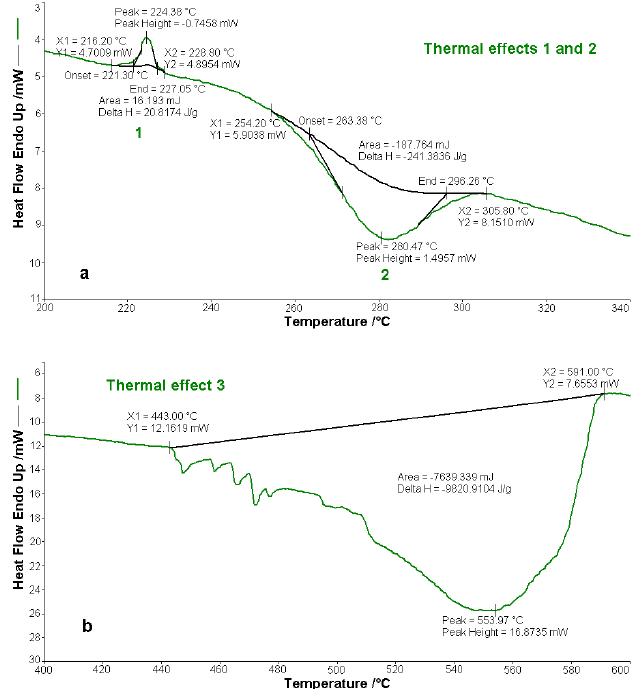
Figure 16. Thermal e ff ects of decomposition of BPA in air: ( a ) thermal e ff ect of melting (1) and thermal e ff ect of the first decomposition (2), ( b ) thermal e ff ect of the second decomposition (3).